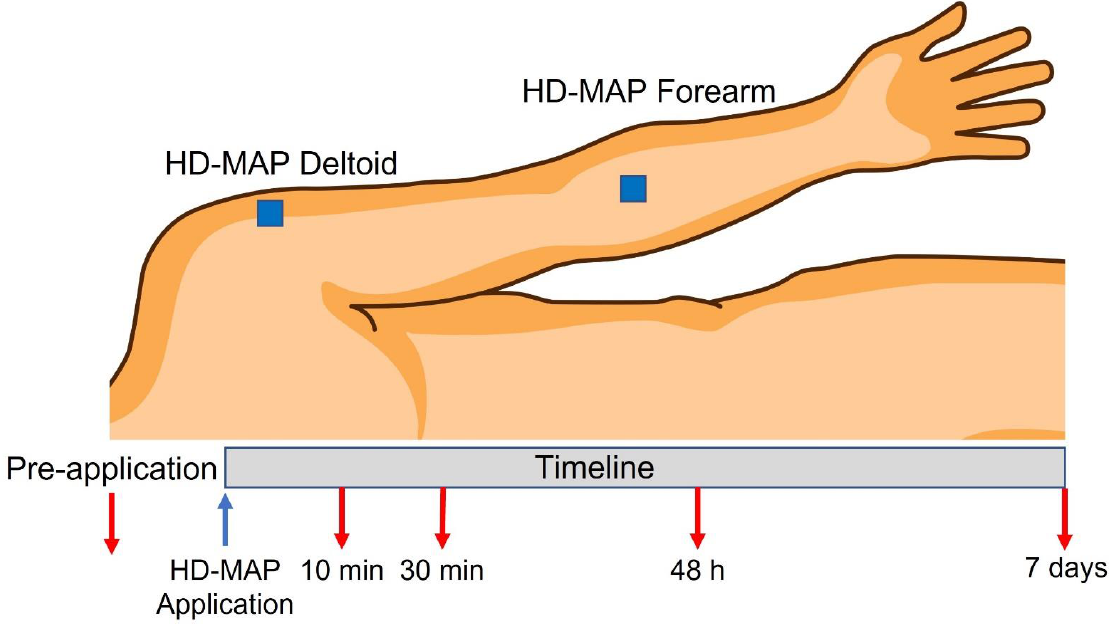
Figure 1. Schedule of the application sites of high-density microneedle array patches (HD-MAP). One HD-MAP applied to the volar forearm and one HD-MAP applied to the lateral deltoid region. Underline showing timepoints for measurements after the application of